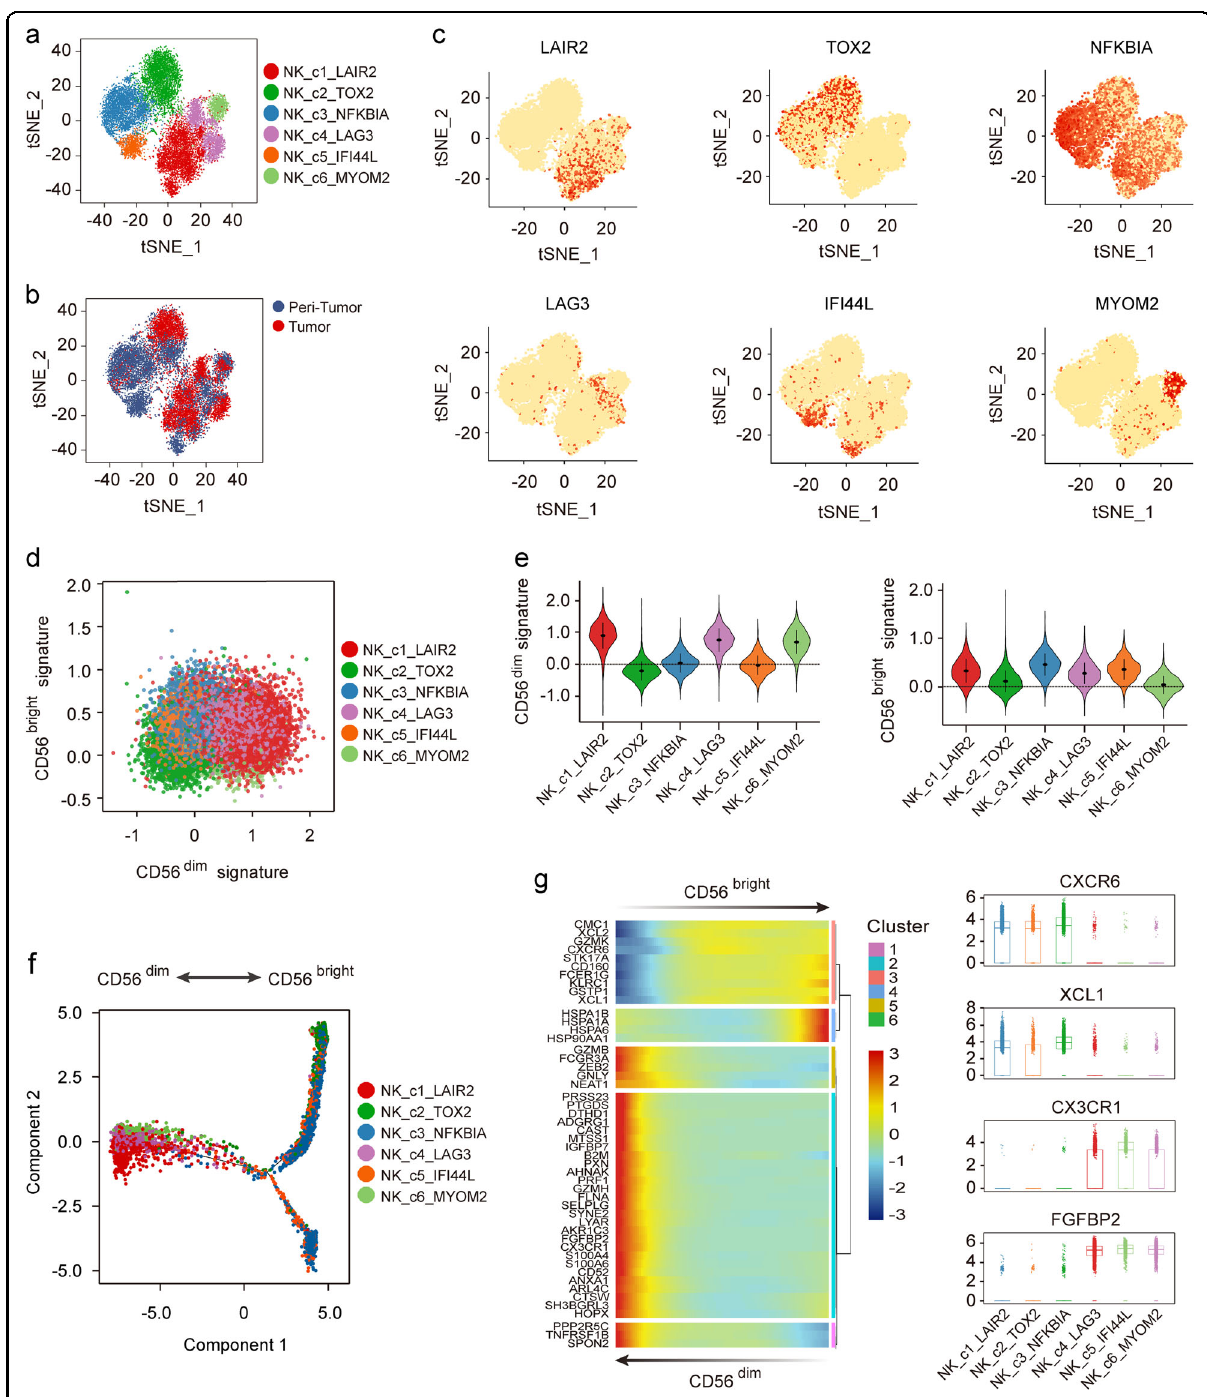
Fig. 4 Different NK subpopulations in HCC tumor and peri-tumor. a t-SNE plot of all NK cells revealed six distinct NK clusters. b t-SNE plots of different NK cell clusters origin. c Expression of canonical marker genes in six NK cell populations. d Module scores of CD56 bright and CD56 dim expression programs de fi ned by Hanna et al. 33 for each NK cell. e Violin plots representing the distribution module score for CD56 dim (left) and CD56 bright (right) for each NK cluster. Error bars indicated the means ± SD. f Trajectory of all clusters of NK cell from tumor sites along pseudotime in a two-dimensional state-space de fi ned by Monocle2. Each point corresponds to a single cell, and each color represents a NK cell cluster. g Differentially expressed genes (rows) along the pseudotime (left) and boxplots showing the expression of CXCR6 , XCL1 , CX3CR1 , and FGFBP2